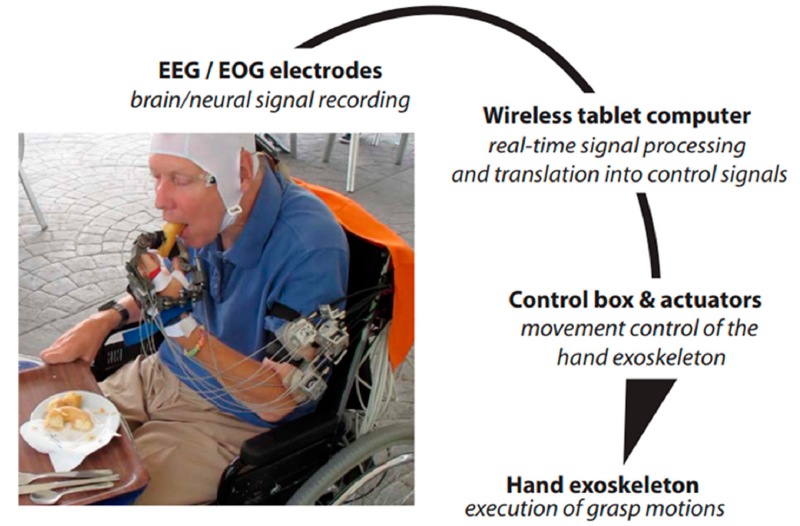
Figure 7. Scheme of the process pipeline to control the exoskeleton of the hand. Adapted with permission from Ref. [99]. 2022, S.R. Soekadar et al.